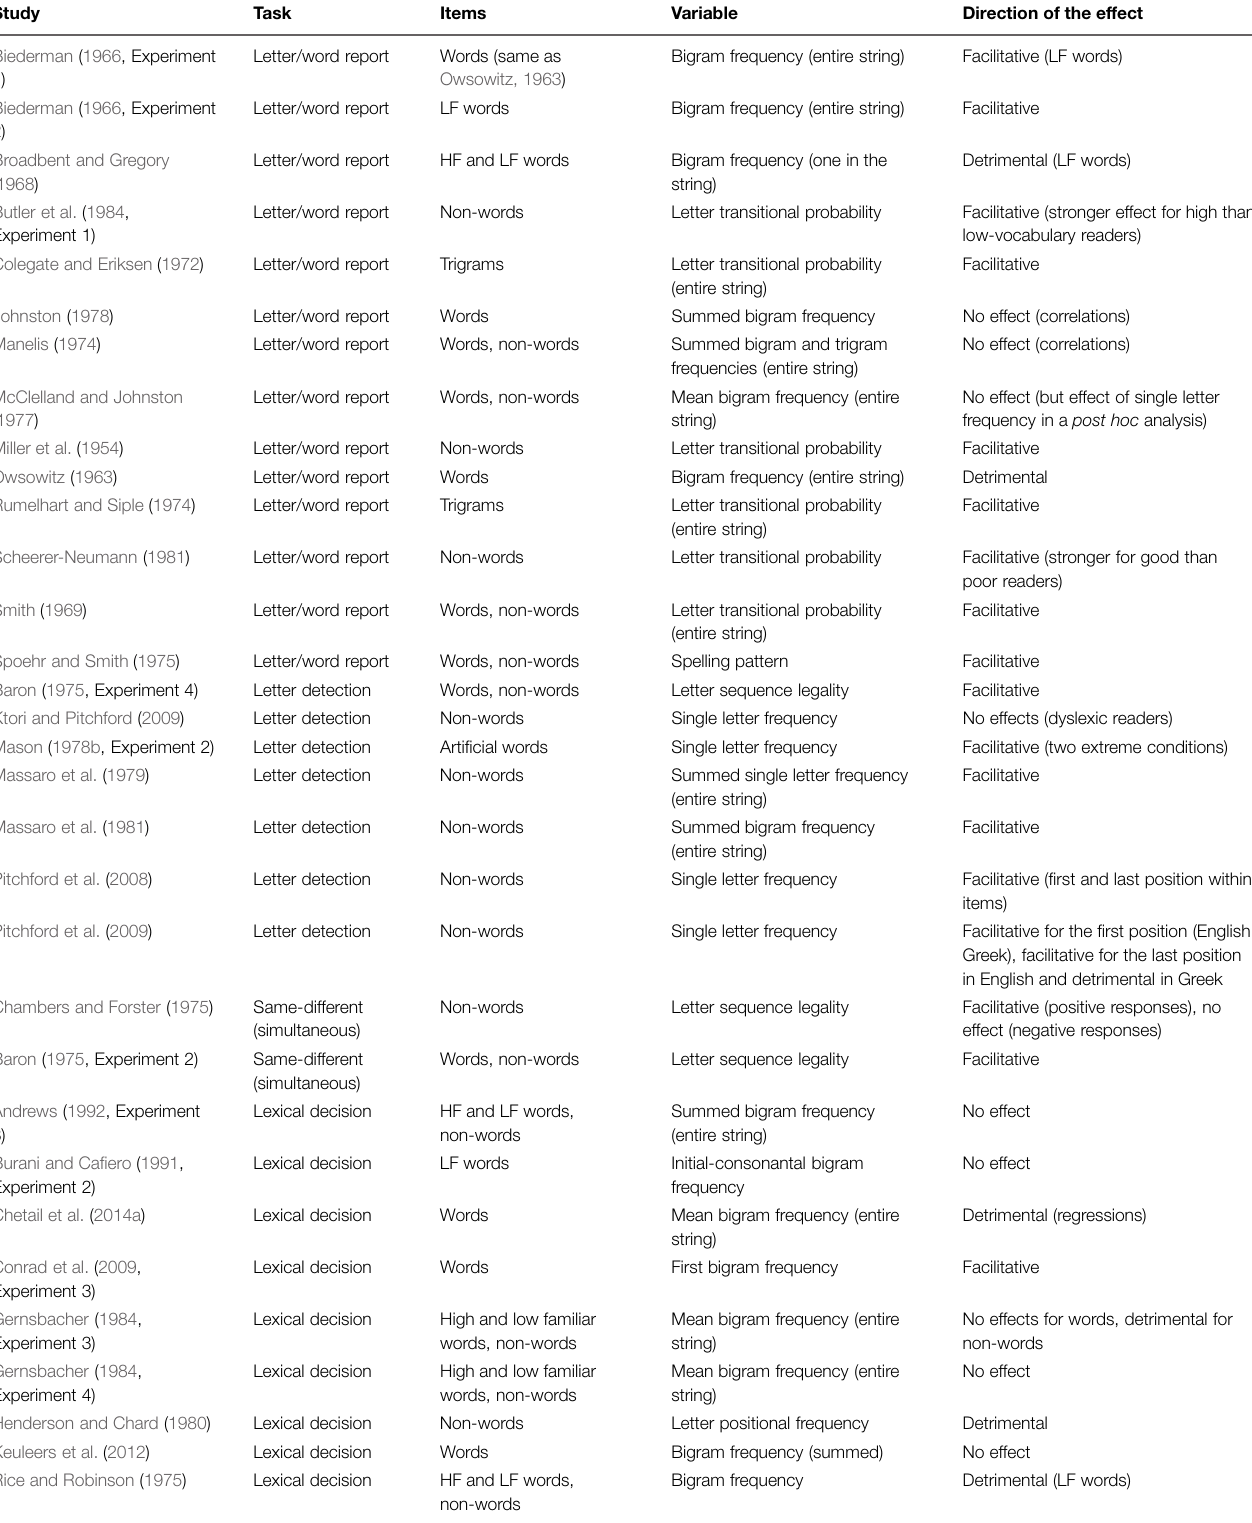
TABLE 1 | Summary of the main behavioral studies on orthographic redundancy with a direct manipulation of n -gram frequency and/or letter transitional probability (ordered by task).